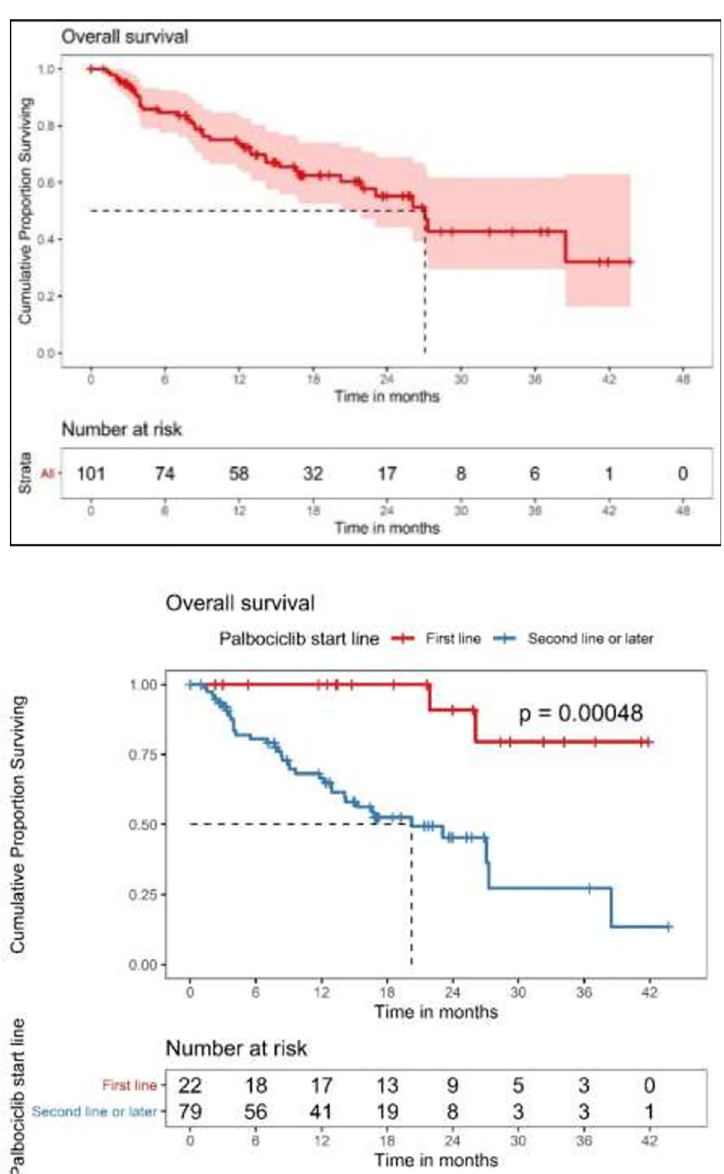
Fig 3. A. Overall survival in the study population. B. Overall survival in patients who received CDK 4/6 inhibitor in first-line versus those who received it in second or later line